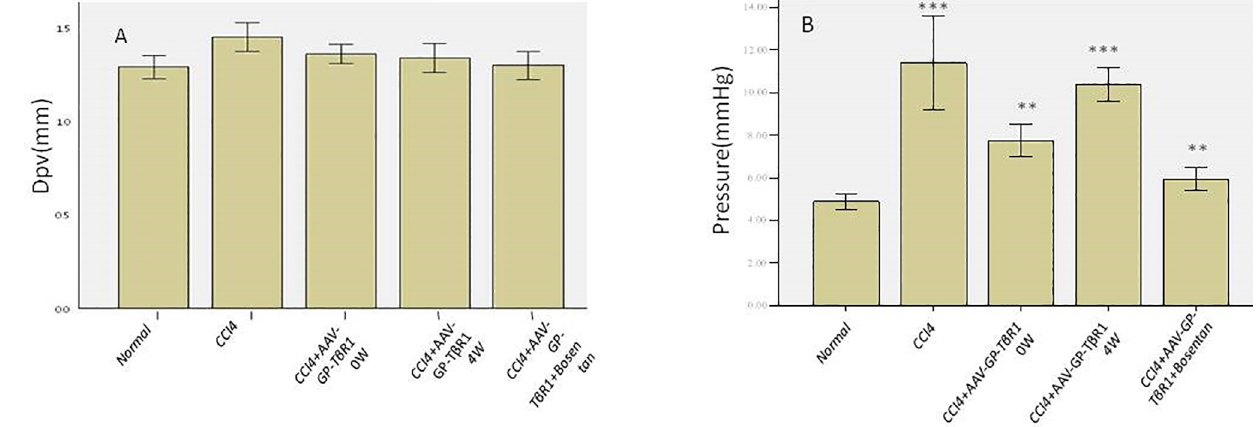
Fig 8. Comparison of portal vein diameter and portal venous pressure among the various groups: (A) portal vein diameter did not differ significantly among the groups. (B) Portal venous pressure values differed significantly between the experimental groups and the control group.